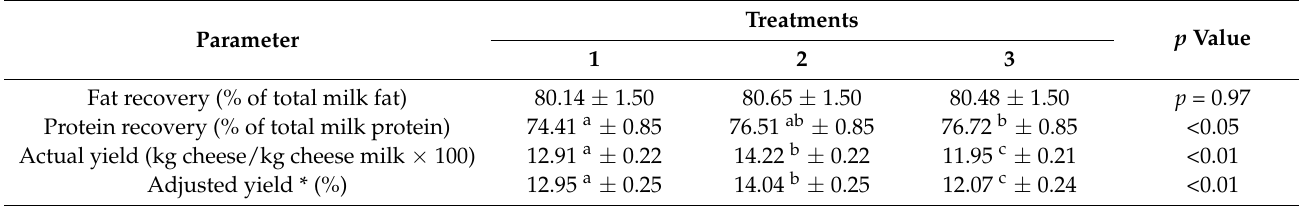
Table 4. Effect of milk standardization on fat and protein recovery to Liˇcki škripavac cheese and actual and adjusted cheese yield (least square means ± standard